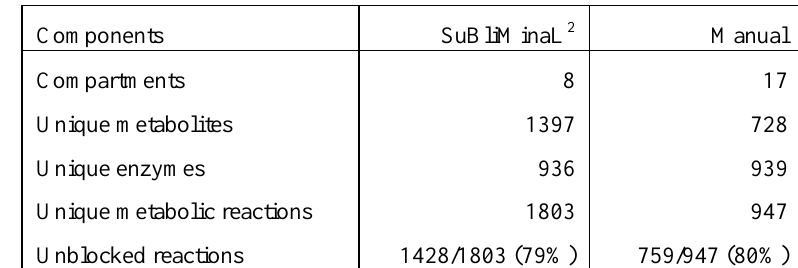
Table 1: Comparison of SuBliMinaL- and manually-generated S. cerevisiae metabolic reconstructions. Values for unique metabolites, enzymes and metabolic reactions refer to “flattened” versions of the reconstructions, in which metabolites and enzymes in different intracellular compartments are considered one. In the case of SuBliMinaL, unblocked reactions were calculated on a minimal growth medium as described